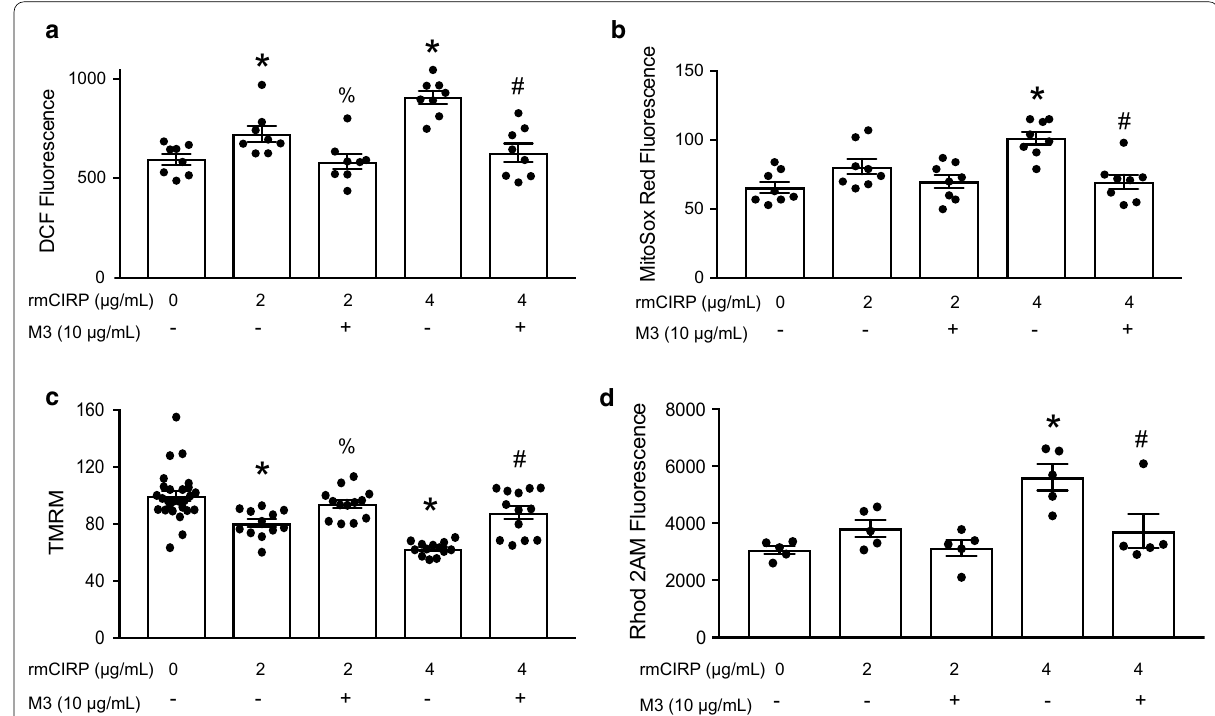
Fig. 7 rmCIRP increases oxidative stress in cardiomyocytes and causes mitochondrial dysfunction. Primary murine neonatal cardiomyocytes were isolated. Cardiomyocyte and mitochondrial oxidative stress were quantified using a DCF (N 8/group) and b MitoSOX Red fluorescence (N 8/ = = group). Mitochondrial membrane potential and calcium levels was assessed using c Tetramethylrhodamine methyl ester (TMRM) (PBS 27 and = 13 per group for rest) and d Rohd2 AM (N 5/group) fluorescence. After rmCIRP stimulation, there was a significant dose‑dependent increase in = cardiomyocyte and mitochondrial‑specific reactive oxygen species; this was ameliorated by M3 ( a , b ). Stimulation of cardiomyocytes with rmCIRP resulted in a reduction in mitochondrial membrane potential while M3 treatment returned membrane potential to near baseline ( c ). rmCIRP caused mitochondrial calcium overload; this was inhibited by M3 ( d ). Data shown are the results of two to three independent experiments. Multiple groups were compared by one‑way ANOVA and Tukey method (*p < 0.05 vs. PBS control; % p < 0.05 vs 2 µg/mL rmCIRP, # p < 0.05 vs 4 µg/mL